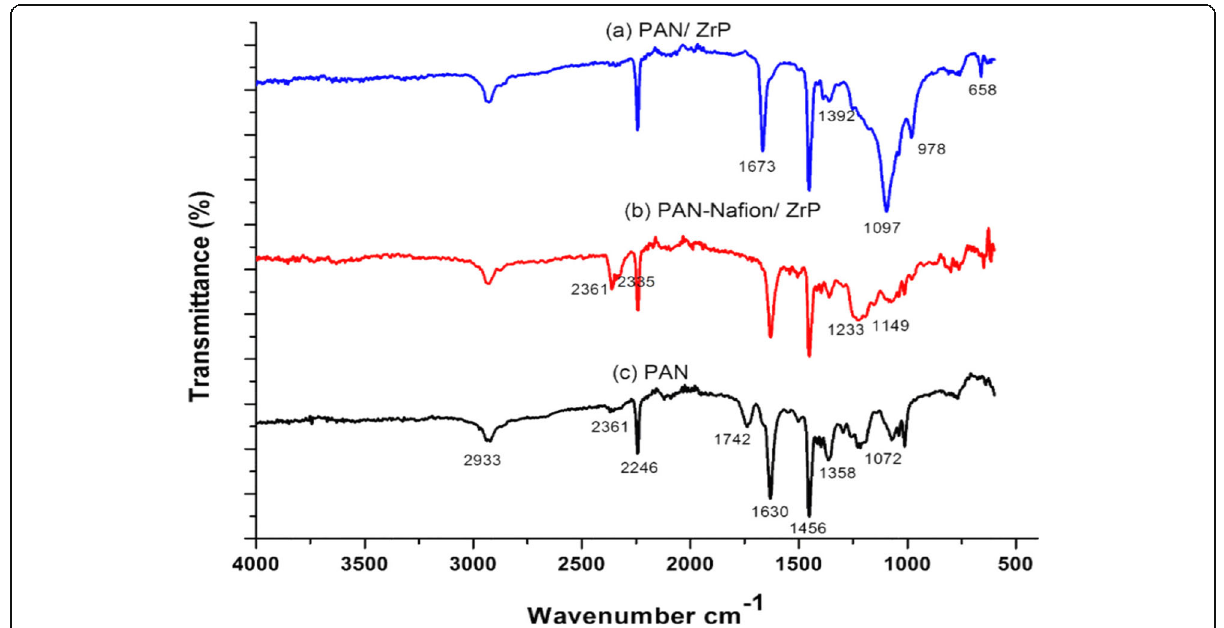
Fig. 5 FTIR spectra of a PAN/ZrP nanofibres, b PAN-Nafion/ZrP nanofibres and c PAN